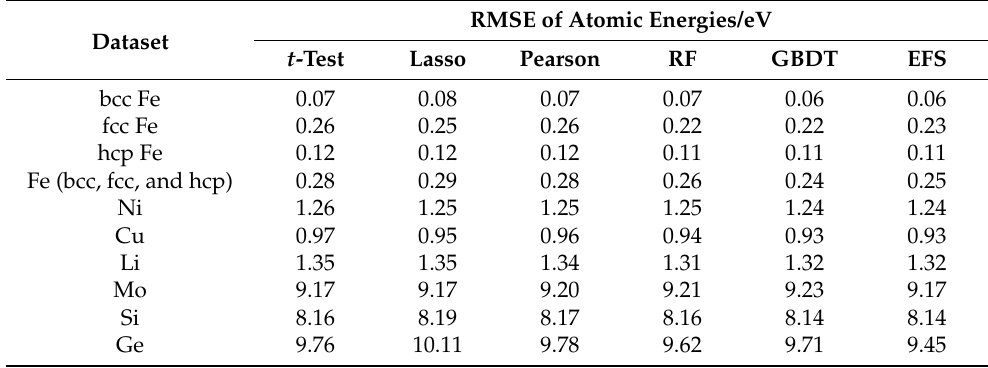
Table 4. Energy RMSE comparison between EFS and benchmark methods on SNAP.